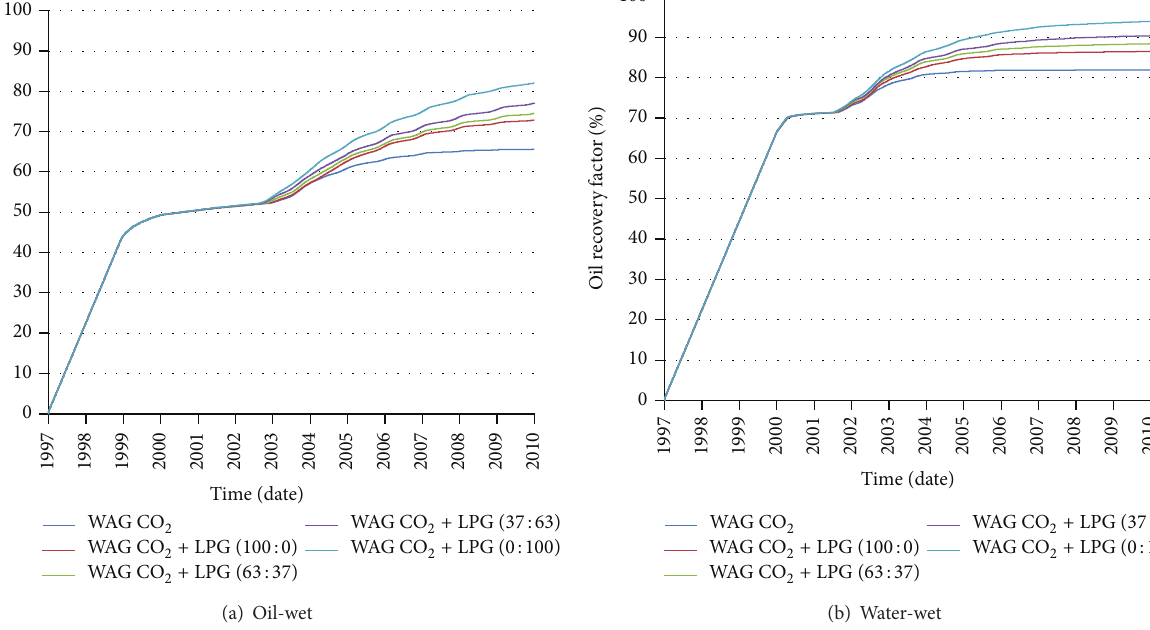
Figure 6: Oil recovery factors with LPG composition for different wettability conditions (LPG mole fraction of injection gas: